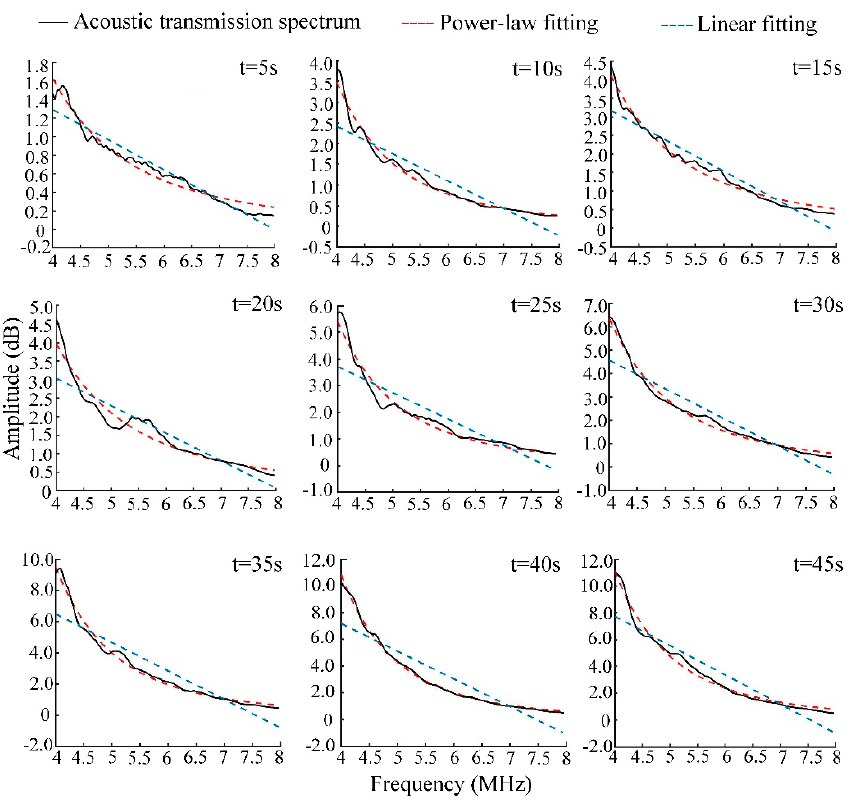
Figure 2. ATS of volunteer 1 every 5 s during the SC process.